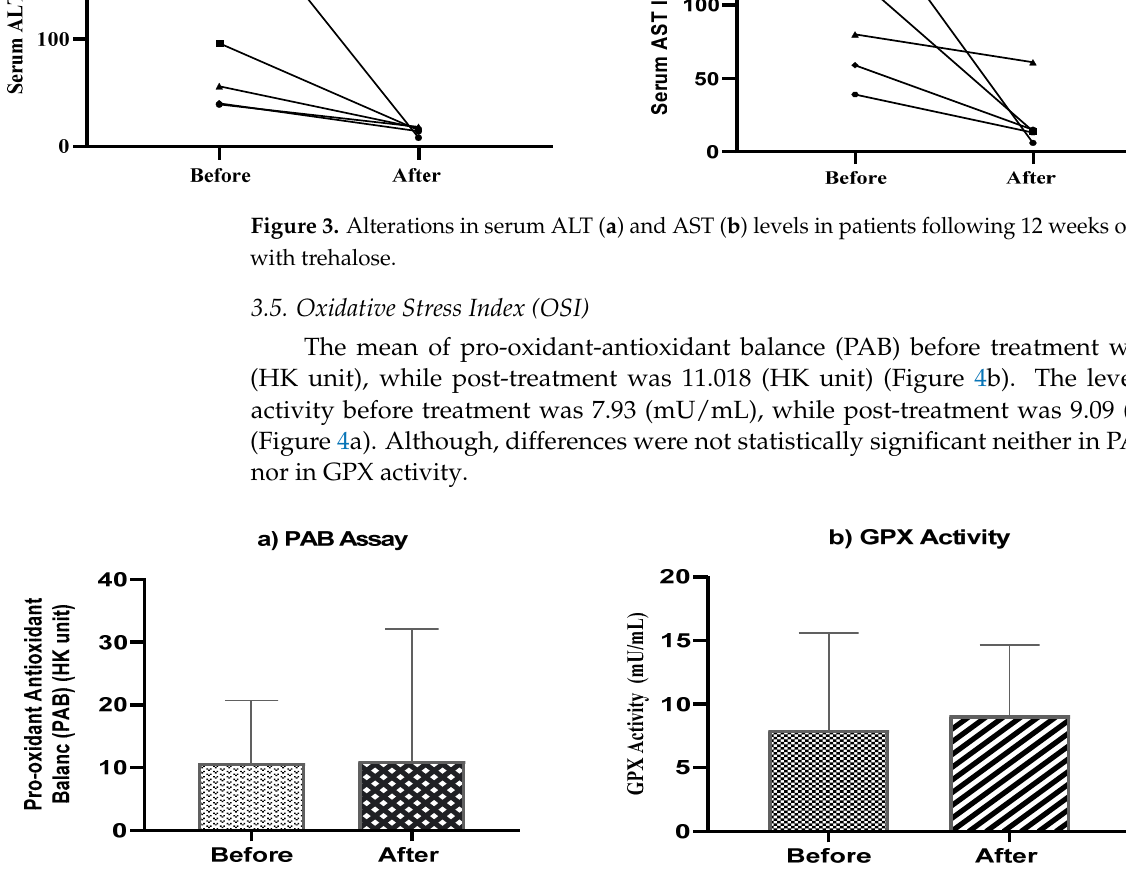
Figure 4. ( a ) Mean serum pro-oxidant antioxidant balance (PAB) and ( b ) mean serum activities of GPX (mU/mL) at baseline and end of the study.